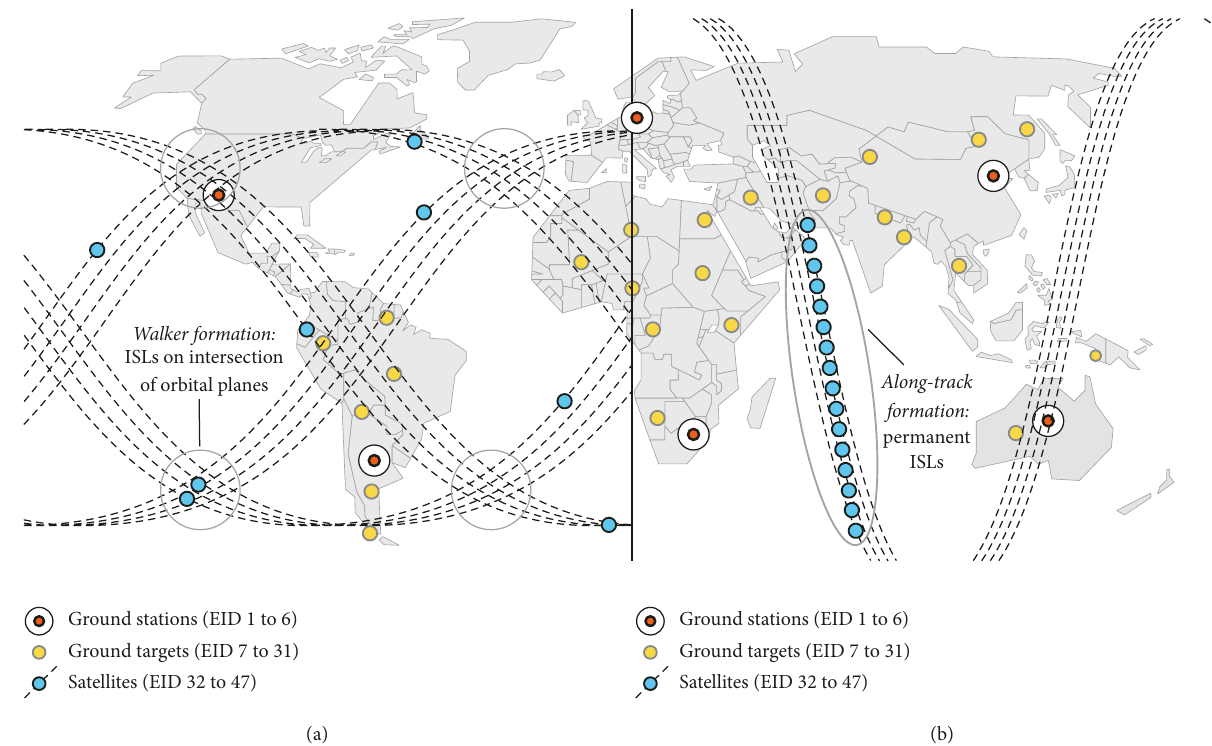
Figure 6: Simulation case studies: (a) Walker formation and (b) along-track